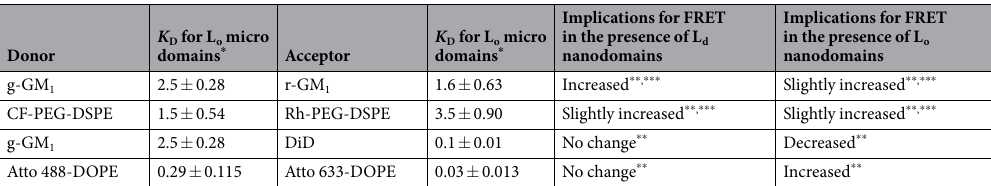
Table 2. Distribution constants K D of probes for L o microdomains and implications for FRET in the presence of L d or L o domains. Note that K D for L d nanodomains are shown in Table 1. * Determined by intensity measurements (see SI) in